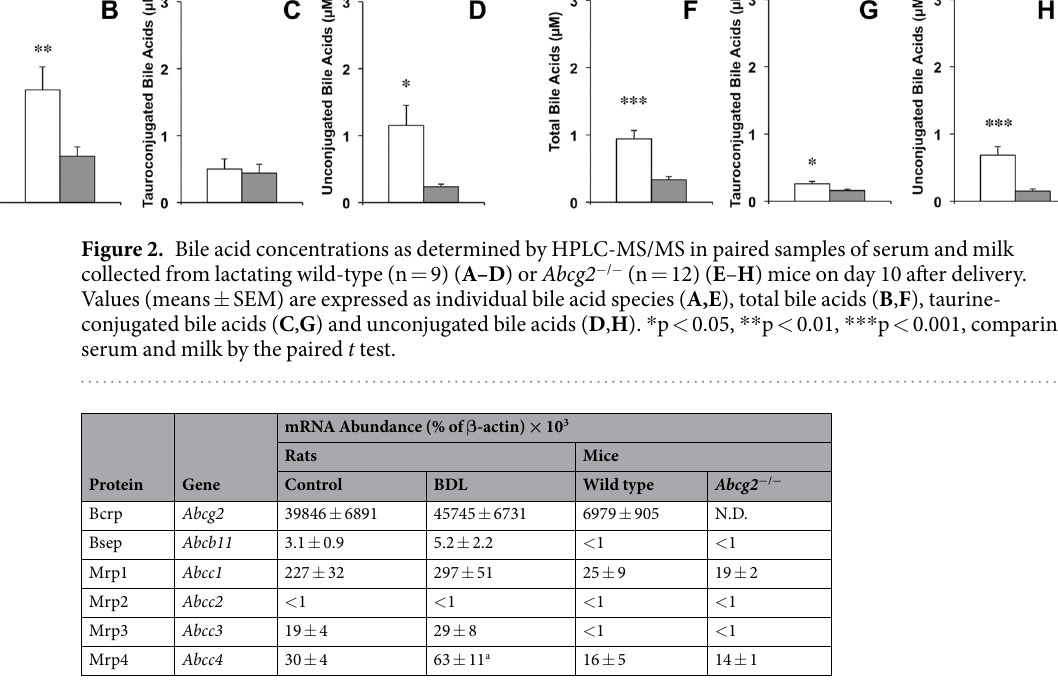
Table 1. Relative mRNA levels of ABC transporters in the mammary gland of breastfeeding rats and mice. Steady-state levels of mRNA in mammary gland tissue obtained from control and bile duct-ligated (BDL) rats, as well as wild-type and Abcg2 − / − mice on day 10 ± 1 post-partum . Values are mean ± SEM, from measurements by RT-QPCR of samples from 6 animals per group, expressed as percentage of the abundance of mRNA of β -actin in each sample a . p < 0.05 as compared with control rats or wild-type mice by the Student t -test. N.D., not